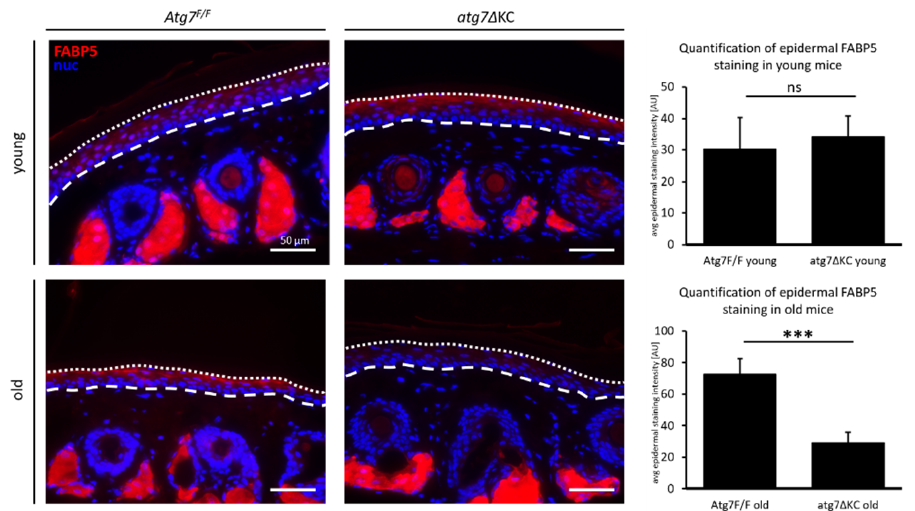
Figure 4. Expression of FABP5 in the tail skin of young and old Atg7F/F or atg7 ∆ KC mice—epidermal FABP5 is strongly reduced in atg7 ∆ KC. PFA-fixed, paraffin-embedded tail cross sections were stained with anti-FABP5 antibody and the nuclear dye, Hoechst. Bar graphs show quantification of aver- age epidermal FABP5 staining intensities within the marked areas (dashed lines indicate dermal– epidermal junction and dotted lines, the edge of nucleated areas). Student’s t -test, mean + stan- dard deviation. * marks a significant difference between Atg7 F/F and atg7 ∆ KC, ns non-significant; *** p < 0,001; n = 3 mice per group. Bar: 50 µ